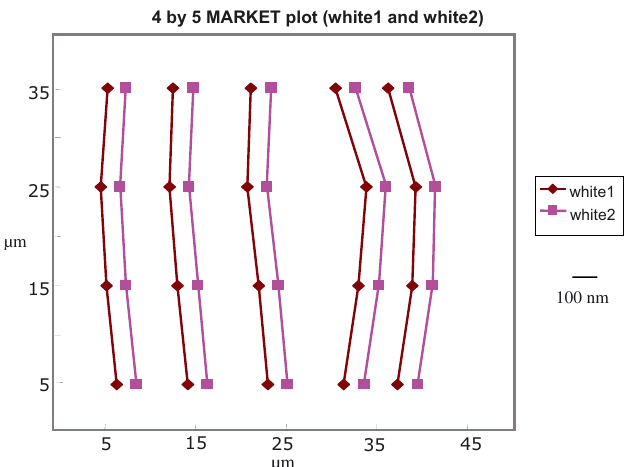
Fig. 7. MARKET plots (4 by 5) for two frames, taken a few seconds apart under white light illumination. The scale bar at right measures the phase difference of each subfield for both frames with the units of phase expressed in